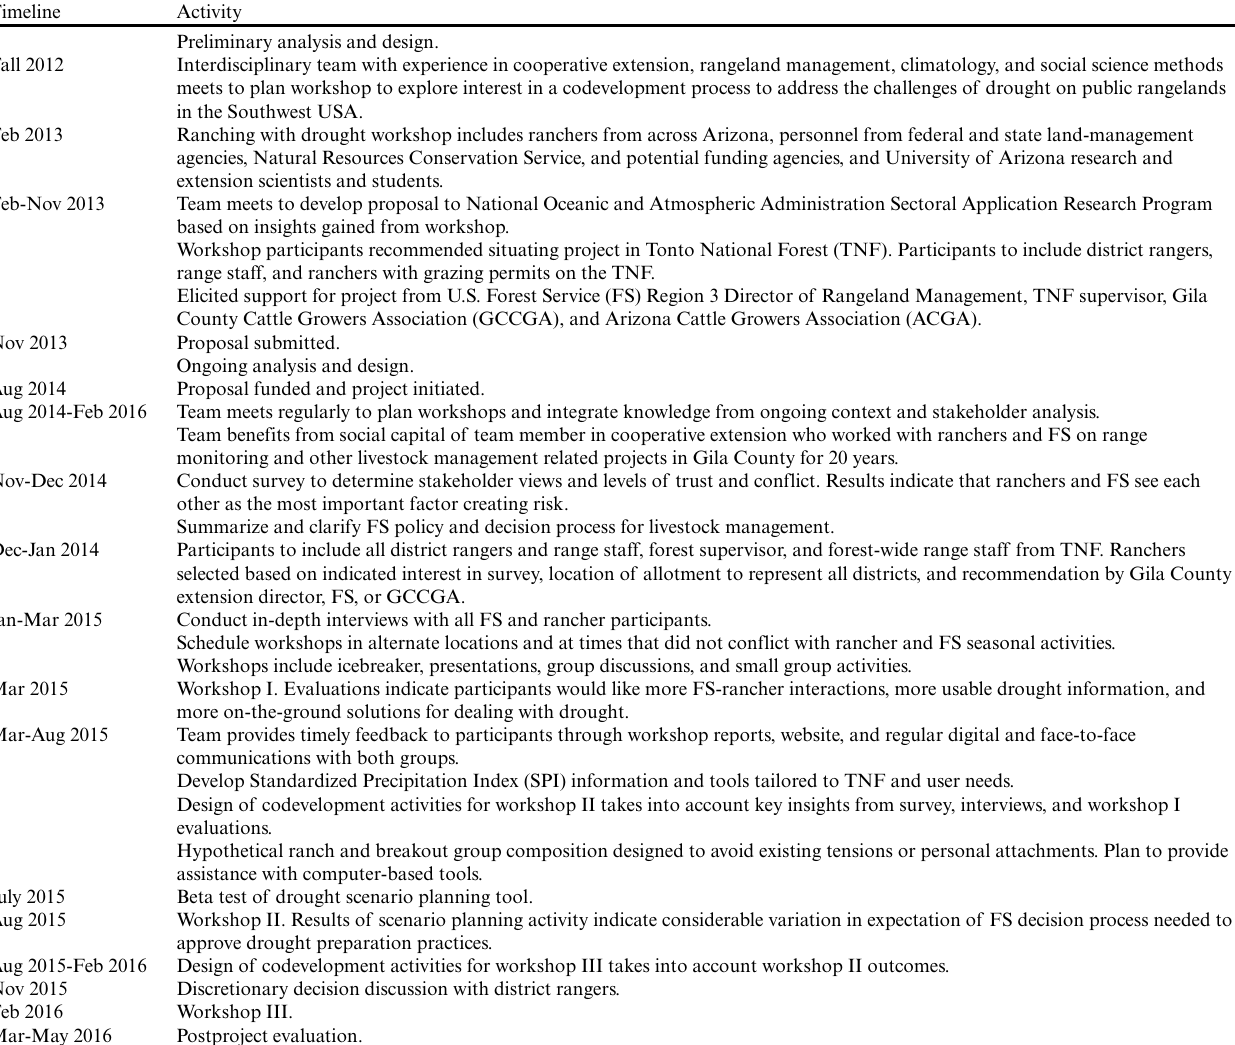
Table 1 . Timeline of codevelopment process to increase preparation for drought on public